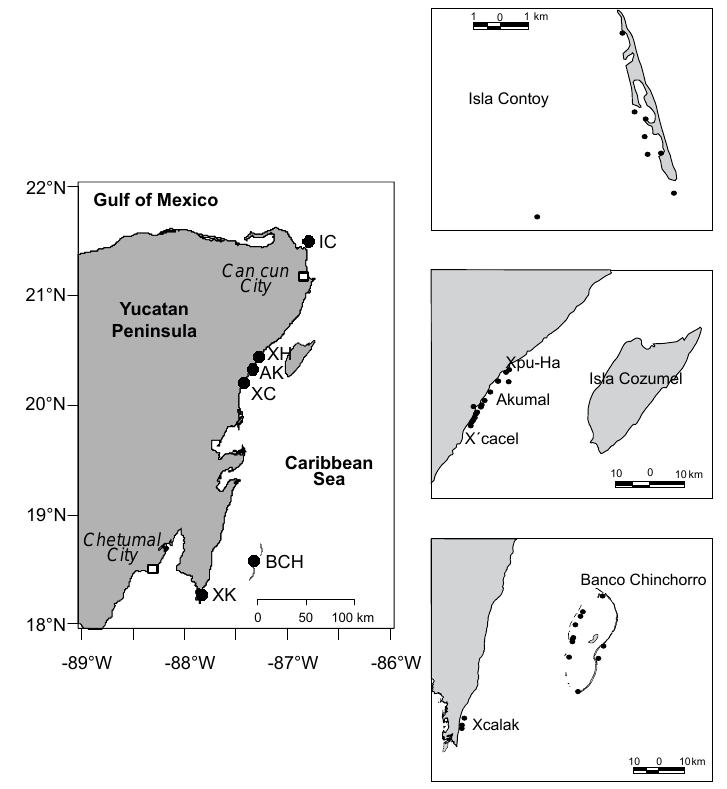
Fig. 1. Map showing the location of the sampling sites in the Mexican Caribbean; Each dot indicates the collection sites distributed along the North-, Central-, and South zones of the Mexican Caribbean